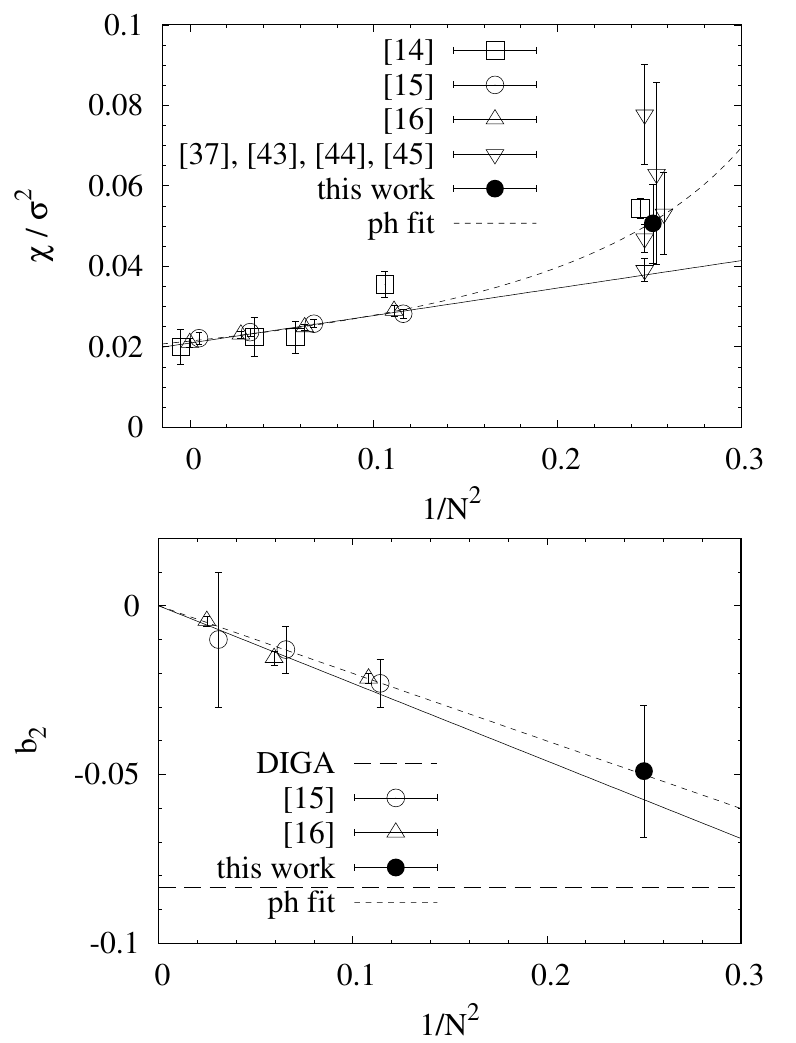
and b , where the numbers in the legend denote the Figure 11 . The N dependence of χ/σ 2 2 str reference numbers. Each data point is slightly shifted horizontally to make it easier to see. The horizontal dashed line in the b plot represents the dilute instanton gas approximation 2